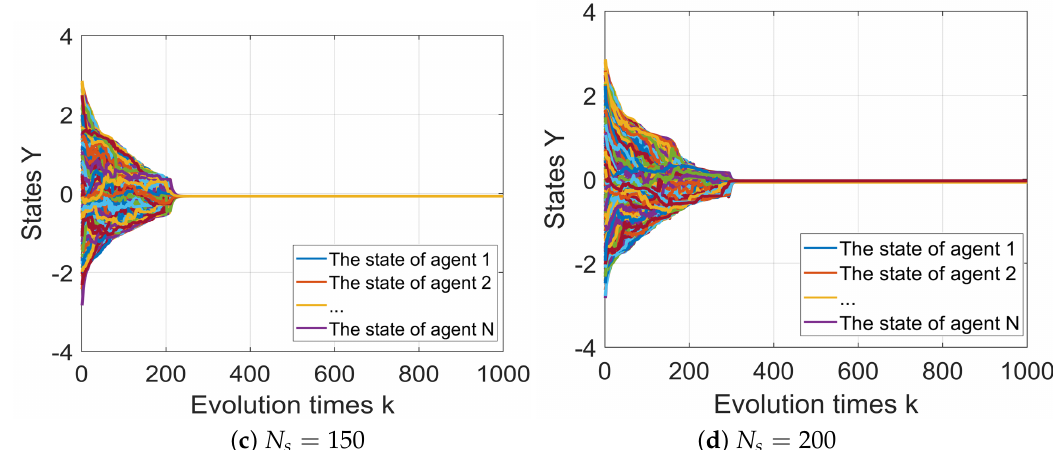
Figure 4. The evolution performance with the different number of agents.